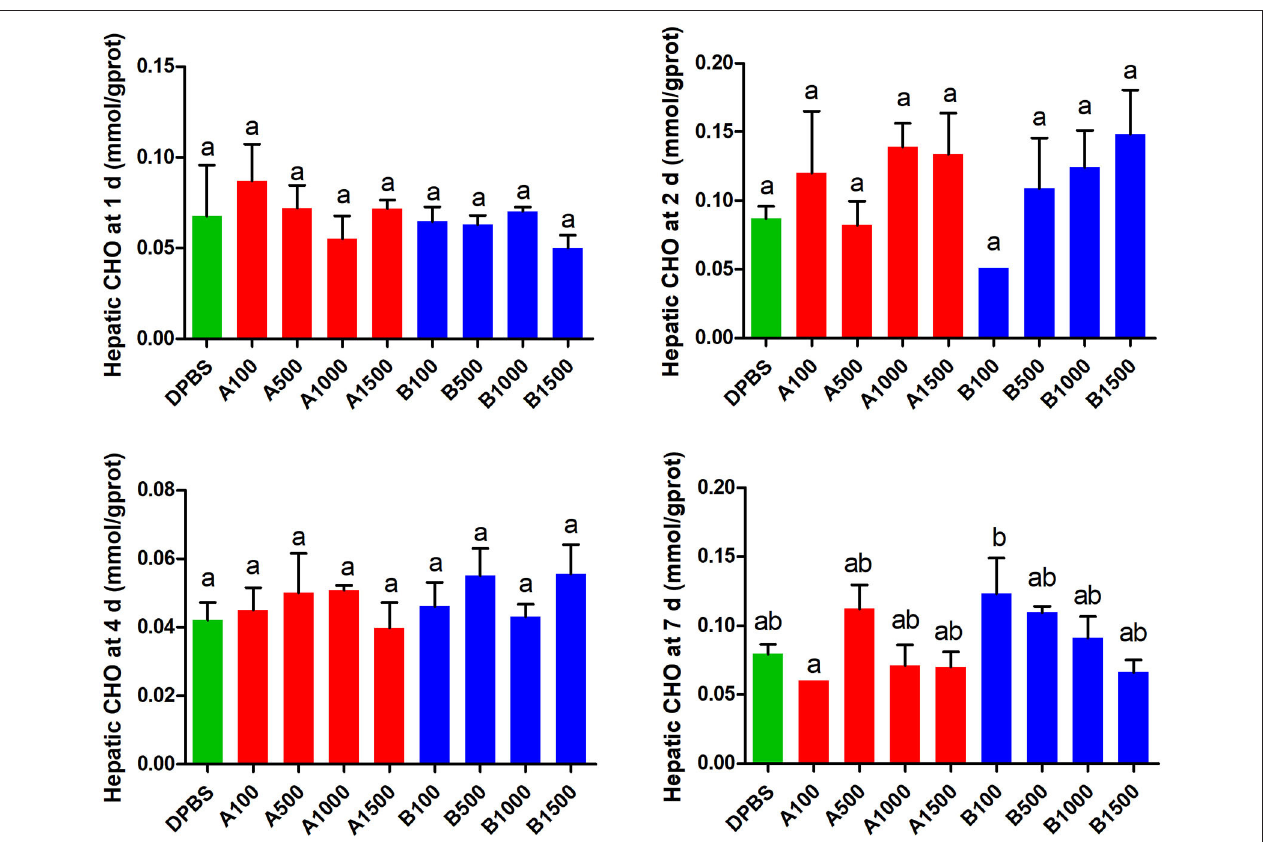
FIGURE 4 | The effects of intraperitoneal injection of LepA and LepB on hepatic CHO levels at 1, 2, 4, and 7 d. Data represent means ± S.E.M ( n = 6). The colors of bars were shaded according to intraperitoneal injection of different solvent (green: DPBS, red: LepA, blue: Lep B). Significance level are marked with different letters ( P < 0.05), compared with the values from DPBS injected mandarin